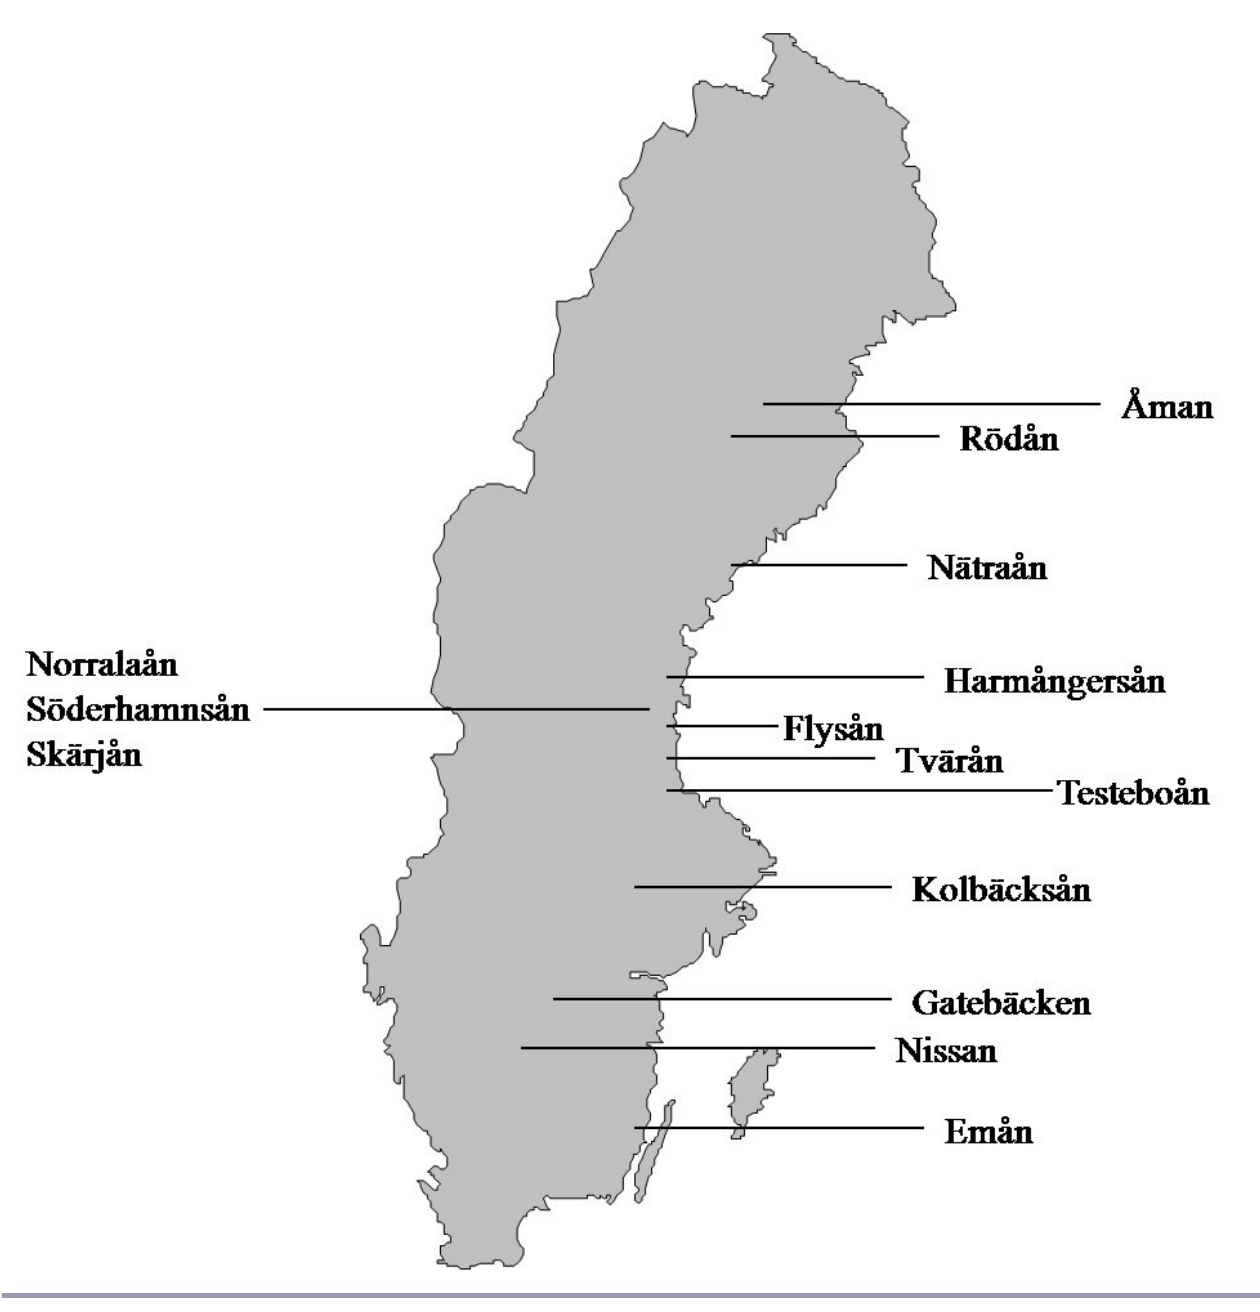
Fig. 1 . Locations of the Swedish streams and dams studied (see also Table